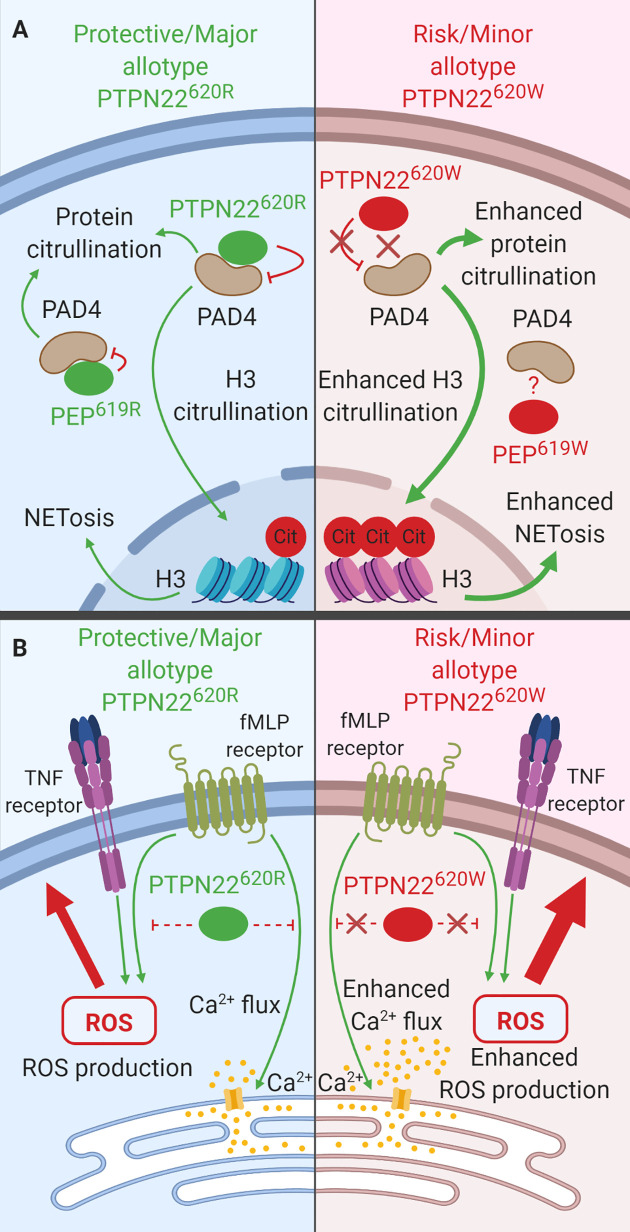
The function of PTPN22 in Neutrophils. (A) PTPN22620R and PEP619R are negative regulators of PAD4 activation and subsequent citrullination of target proteins in neutrophils. PTPN22620W is a loss-of-function variant that potentiates PAD4 activation and citrullination of PAD4 targets. (B) PTPN22620R is a negative regulator of fMLP induced calcium flux and ROS production while PTPN22620W a loss-of-function variant that results in enhanced fMLP-induced calcium flux and ROS.